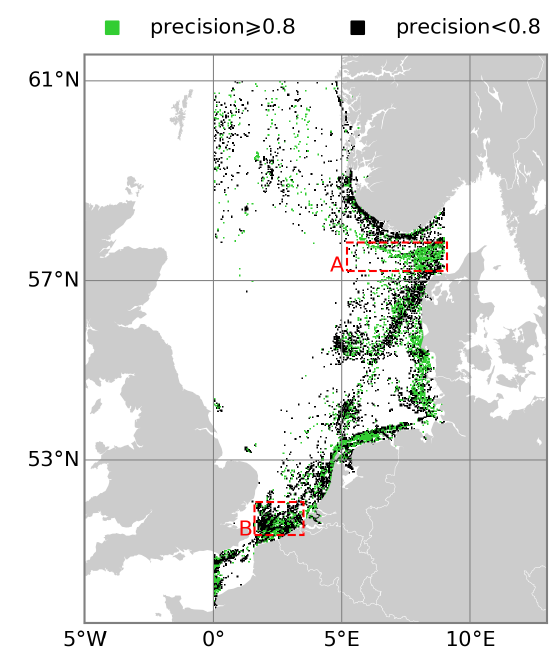
Figure 8. Classification precision for the fishing class. The precision is evaluated over 5 × 5 km bins, for a single test set. Rectangle A and rectangle B highlight zones of high precision and low precision, respectively.